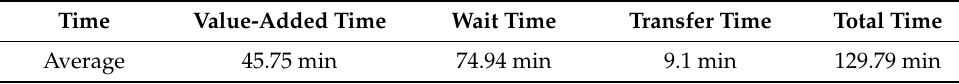
Table 7. Patient’s time in the system in the current state.